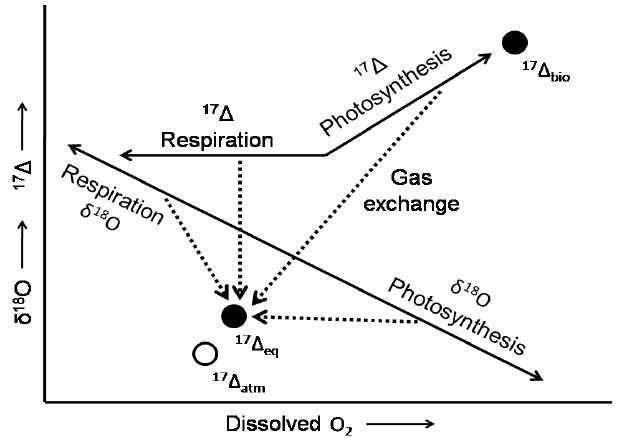
Figure 5. A schematic diagram showing the effects of photosynthe- sis, respiration, and air–water gas exchange on dissolved O 2 con- centrations, δ 18 O and 17 (cid:49) . δ 18 O changes with all the processes and additionally is also affected by mixing. Because of non-mass- dependent processes occurring in the stratosphere, the 17 (cid:49) of O 2 in air has a different signal to the O 2 produced biologically where fractionation is mass-dependent. 17 (cid:49) increases due to photosynthe- sis, decreases due to gas exchange but is not affected by respiration. Respiration removes O 2 and decreases the dissolved O 2 concentra- tion but fractionates O 2 isotopes in a mass-dependent way, which does not affect the relative proportion of δ 17 O and δ 18 O and there- fore the 17 (cid:49) . 17 (cid:49) bio is the maximum value of pure biological sig- nal, which amounts to 17 (cid:49) of water. The slope of 17 (cid:49) increase towards 17 (cid:49) bio is the kinetic slope λ for respiration ( λ = 0 . 518). 17 (cid:49) eq is the O 2 at air–water equilibrium, which has a small offset from 17 (cid:49) atm , which is by definition 0, due to fractionation at equi- librium where δ 17 O and δ 18 O slopes during invasion and evasion follow a slightly different slope to that of